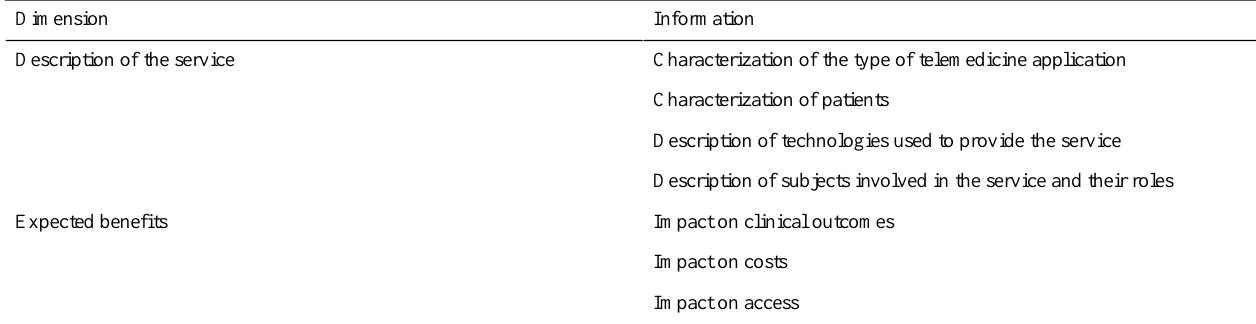
Table 4. Preliminary proposal: description of the proposed telemedicine application